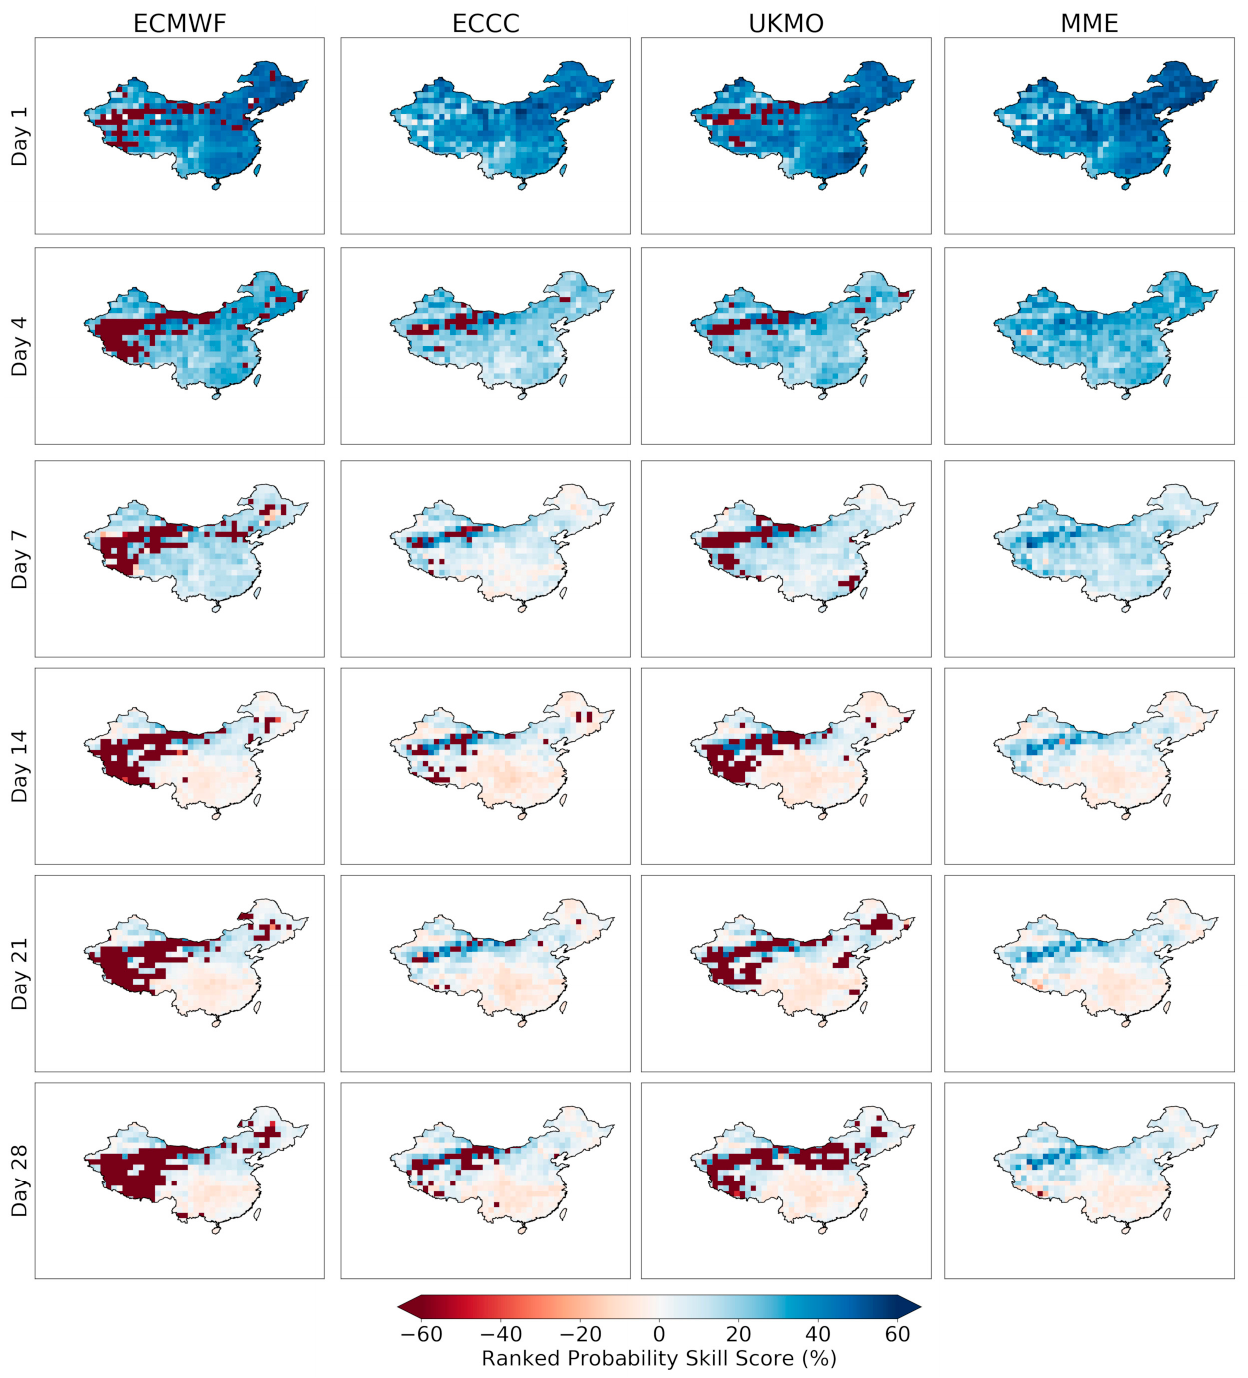
Figure 7. Ranked probability skill score (RPSS) of daily forecasts at different lead times (Day1, 4, 7, 10, 14, 21, 28) of the ECMWF model, the ECCC model, the UKMO model, and the MME model over China during the boreal summer monsoon.